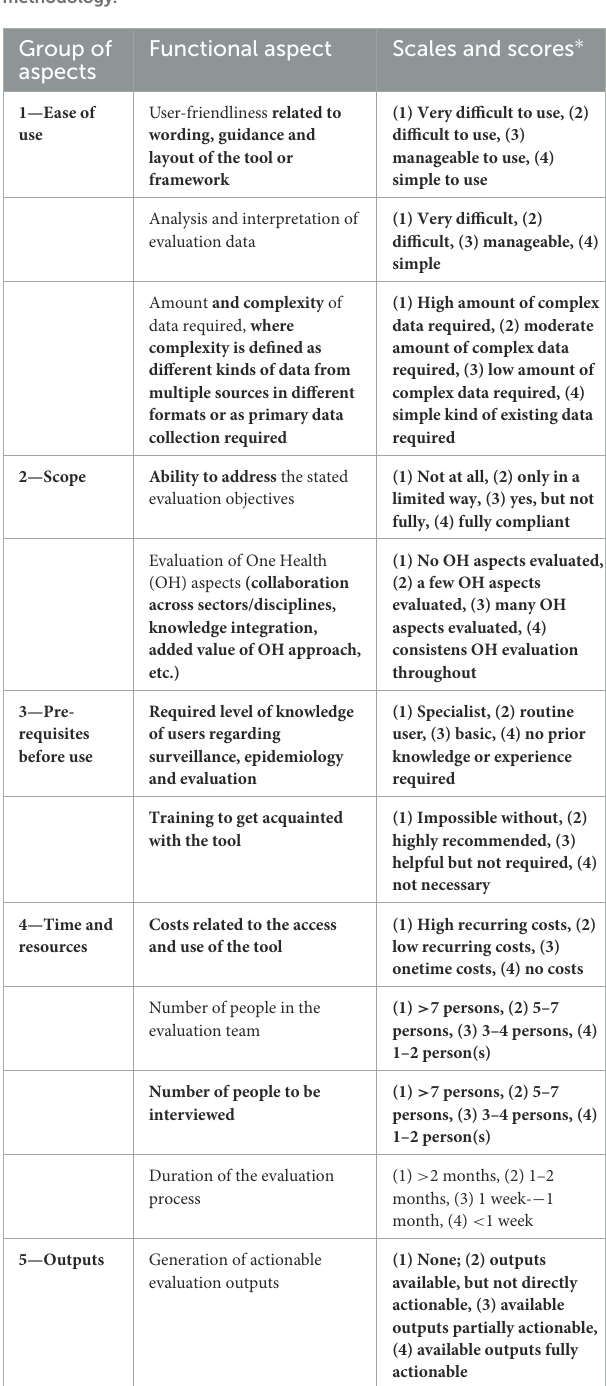
TABLE 1 Description of the updated list of 12 functional aspects, sorted into five groups—text in bold reflects changes to the original